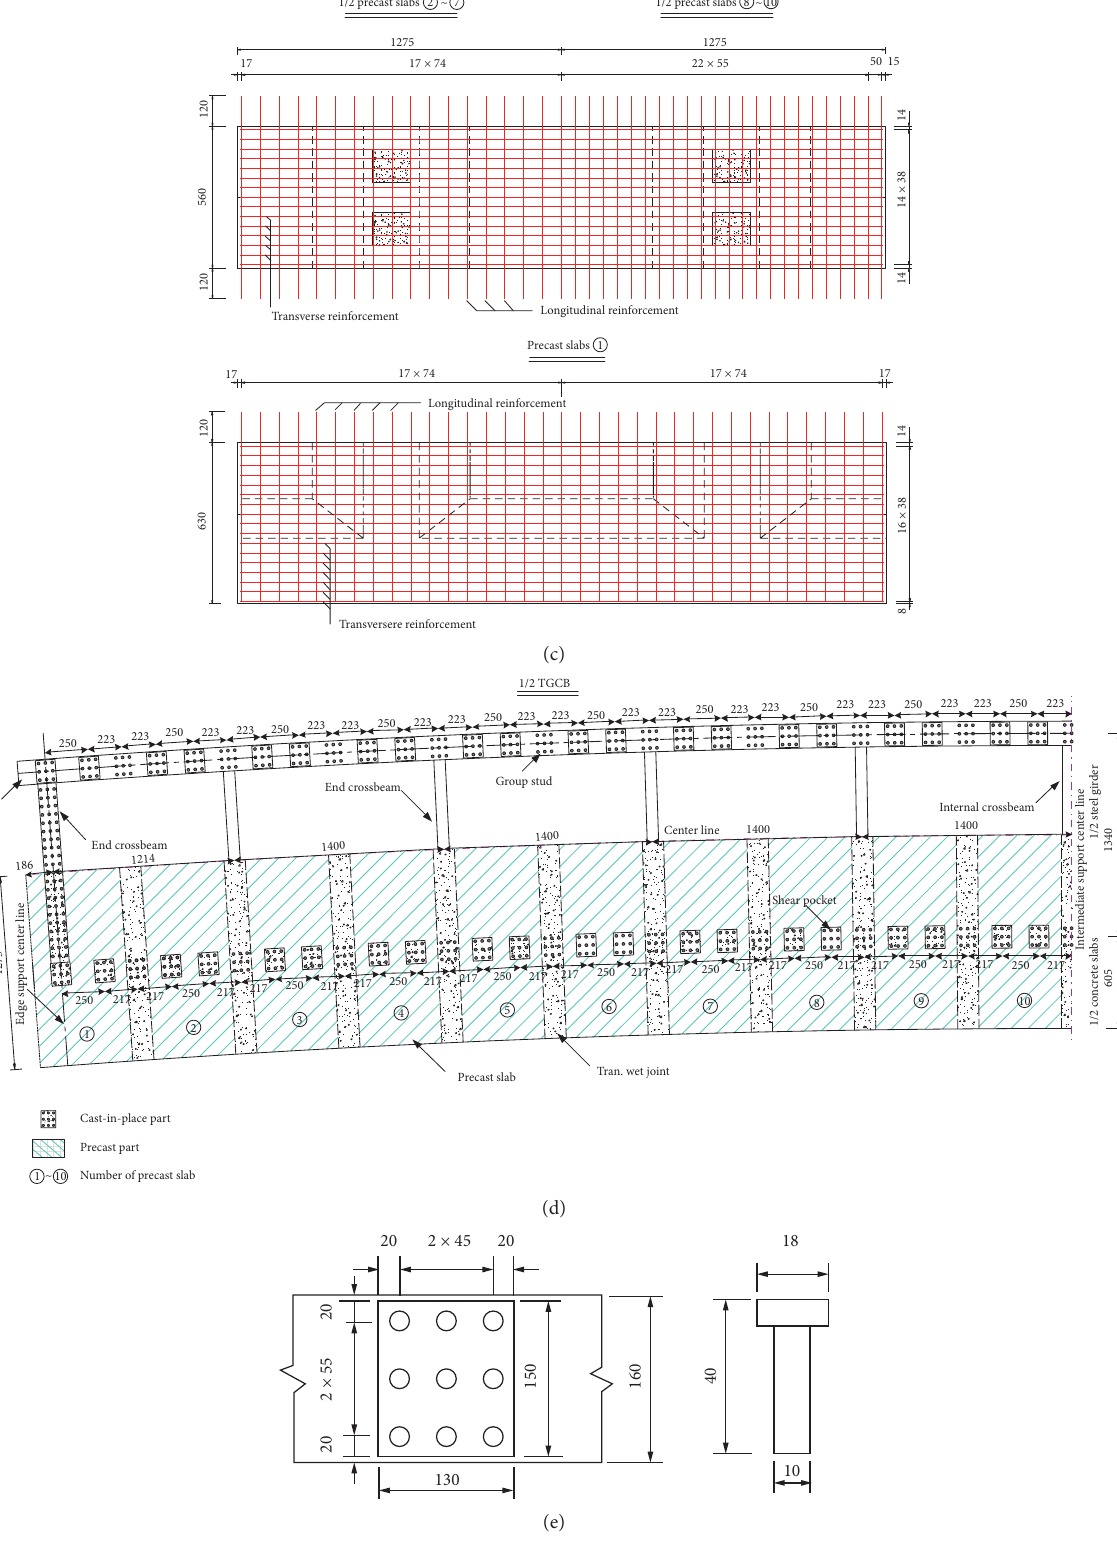
Figure 3: Typical geometry of the bridge model (unit: mm). (a) Vertical view (1/2 span). (b) Cross section. (c) Layout of reinforcement. (d) Top view (1/2 span). (e) Arrangement of the group